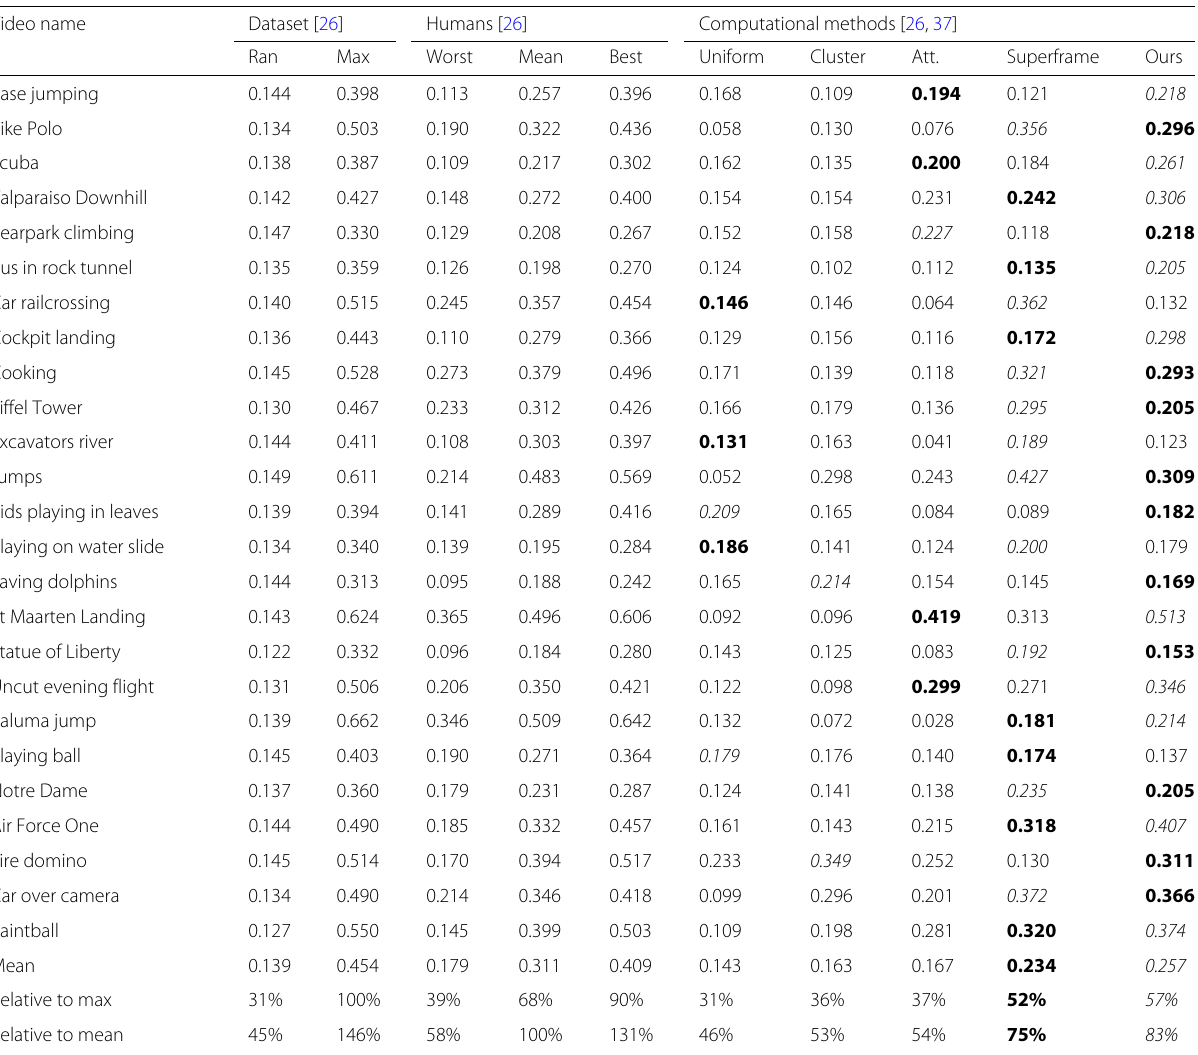
Table 1 Quantitative